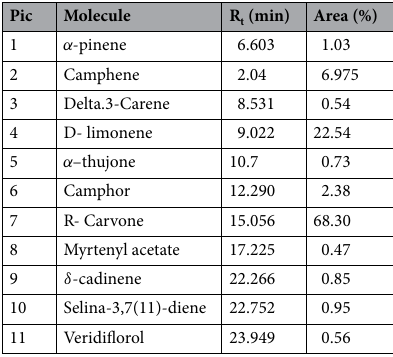
Table 1. Chemical composition of CEO by GC–MS.